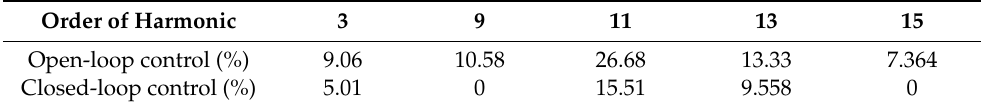
Table 1. Comparisons of harmonic current under different